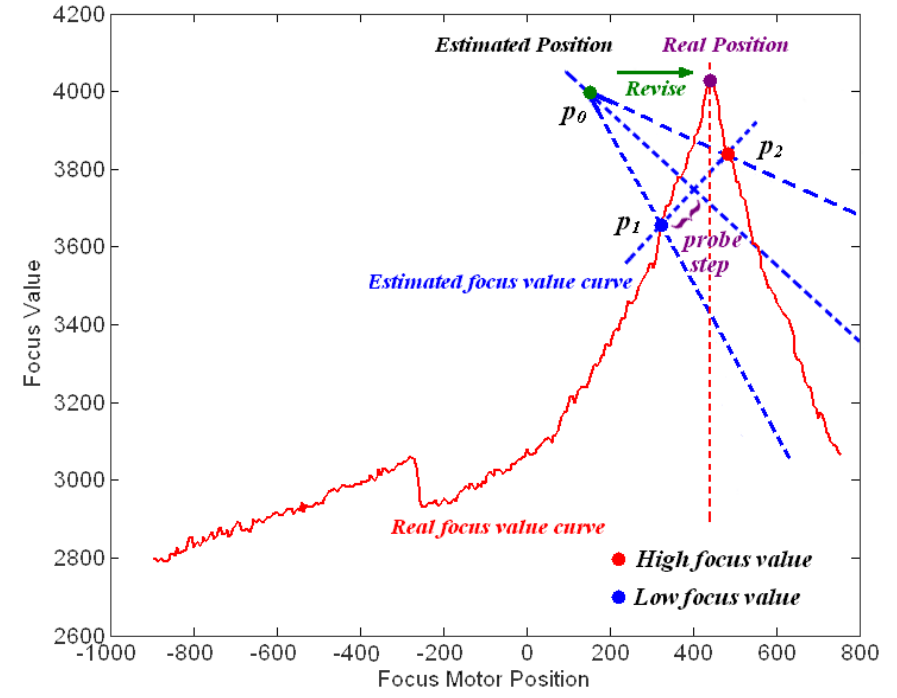
Figure 10. Principle of FZT